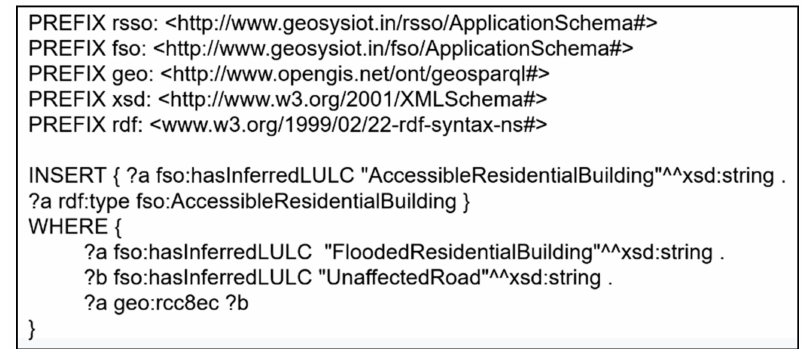
Figure 11. GeoSPARQL query depicting inferencing of “ AccessibleResidentialBuilding ”